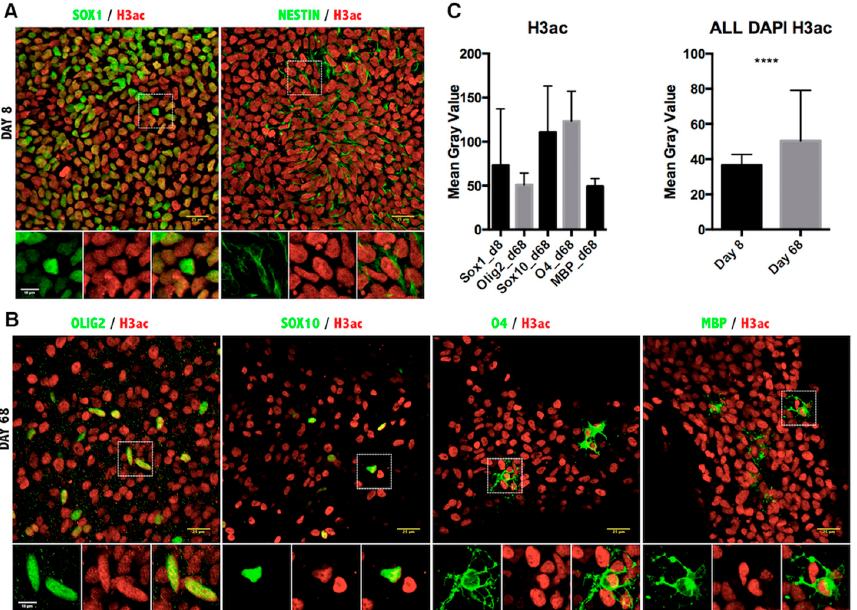
Figure 3. Immunofluorescence analysis of histone H3 pan-acetylation in iPSC-derived oligodendrocyte lineage cells. ( A ) Representative images of Day 8 of the oligodendrocyte differentiation protocol co-stained for NSC markers SOX1, NESTIN and the pan-acetylated histone 3 antibody; ( B ) Images from Day 68 of differentiation co-stained for oligodendrocyte markers OLIG2, SOX10, O4, MBP and H3ac antibody. Scale bar = 25 µm. The magnified view of the broken line box area appears as the inset with the individual channels and the merged image. Scale bar = 10 µm; ( C ) Quantitation of the immunofluorescence signal as the mean gray value in cells expressing the indicated markers ( left ) or in all DAPI-positive cells per field ( right ). Results are represented as the mean with the SD. **** p < 0.0001.